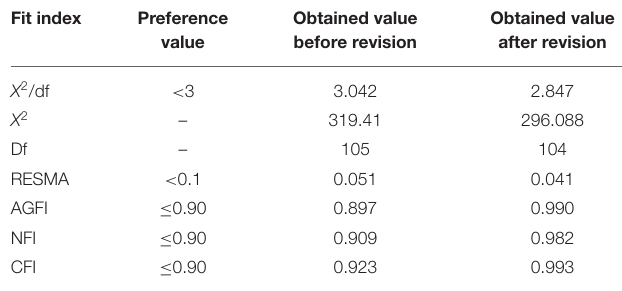
TABLE 7 | Goodness-of-fit indices of the EBs, LSE, LLSs.